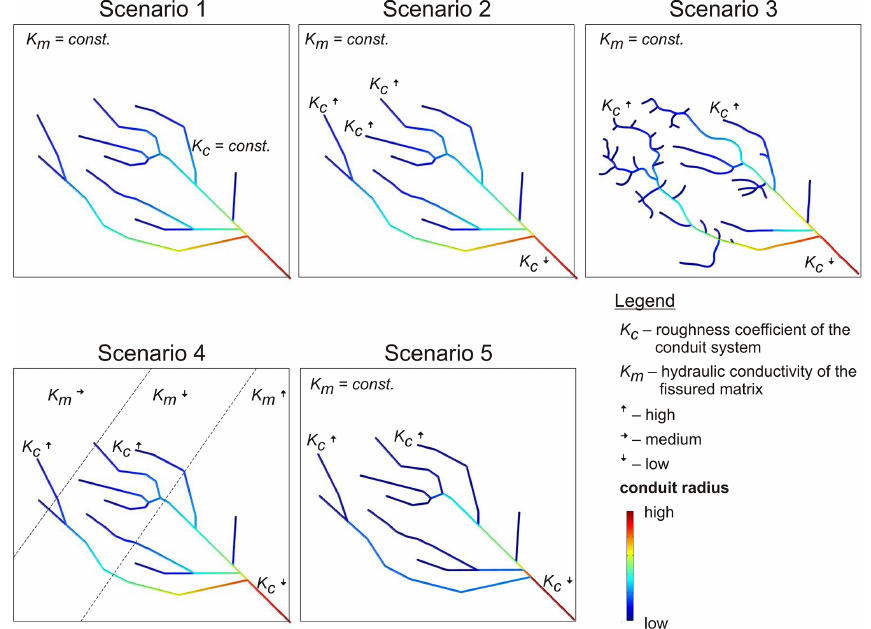
Figure 3. Conceptual overview of the simulated scenarios. The conduit geometry and the varying parameters are shown.